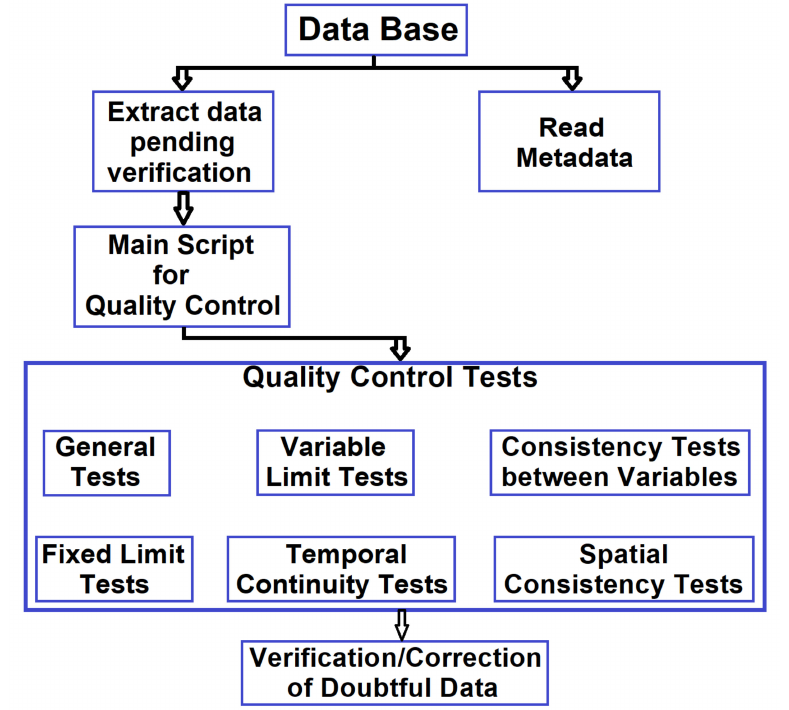
Figure 3. Description of the QCS evaluation routine, from extracting a series from the database to applying the tests and then checking for doubtful data and correcting